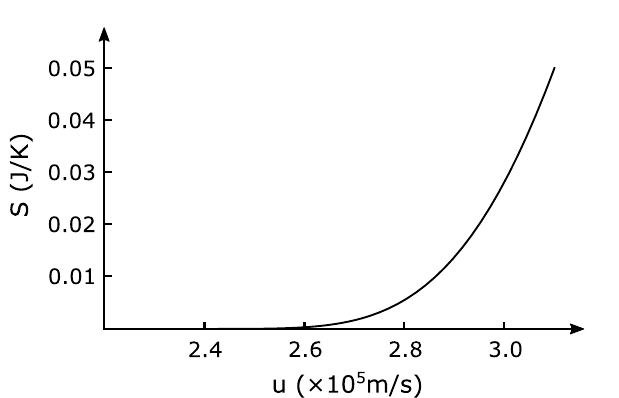
3.01 10 5 m/s (dashed line). = ×